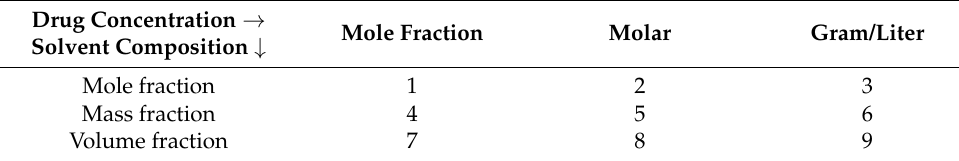
Table 1. The codes of different solubility/solvent composition